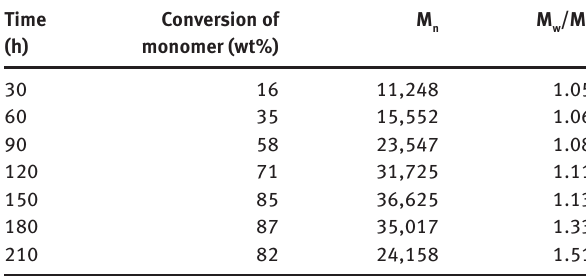
Table 2: Kinetic evolution of tetraphenyltetramethylcyclotetra-